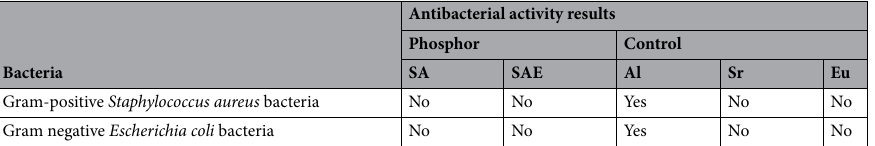
Table 6. The antibacterial activity results of Sr 1−x Al 2 O 4 :Eu x (x = 0.00 and 0.05 ) phosphor (SA and SAE phosphor) with Staphylococcus aureus ( S. aureus ) and Escherichia coli ( E. coil ) bacteria.